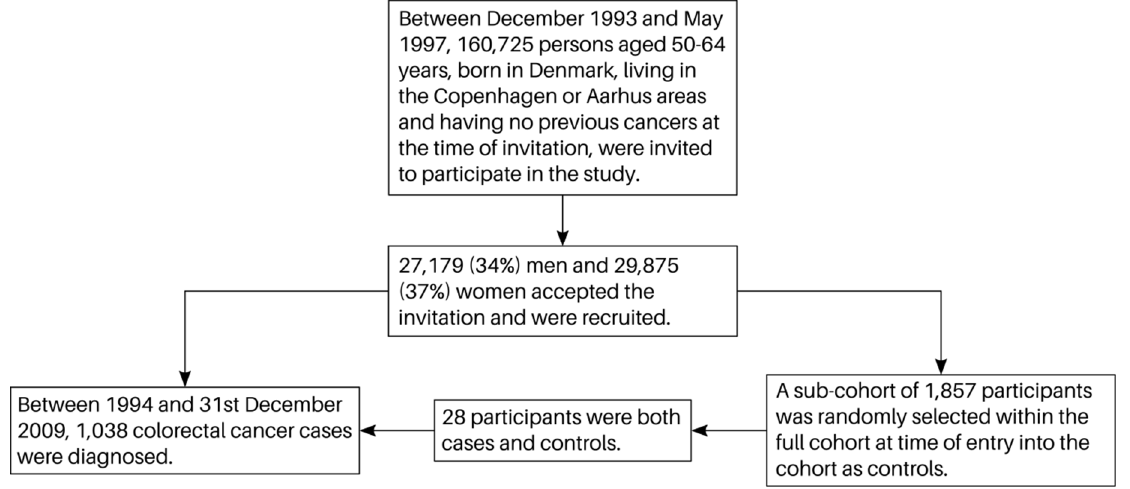
Figure 1. Flow chart of study participants.